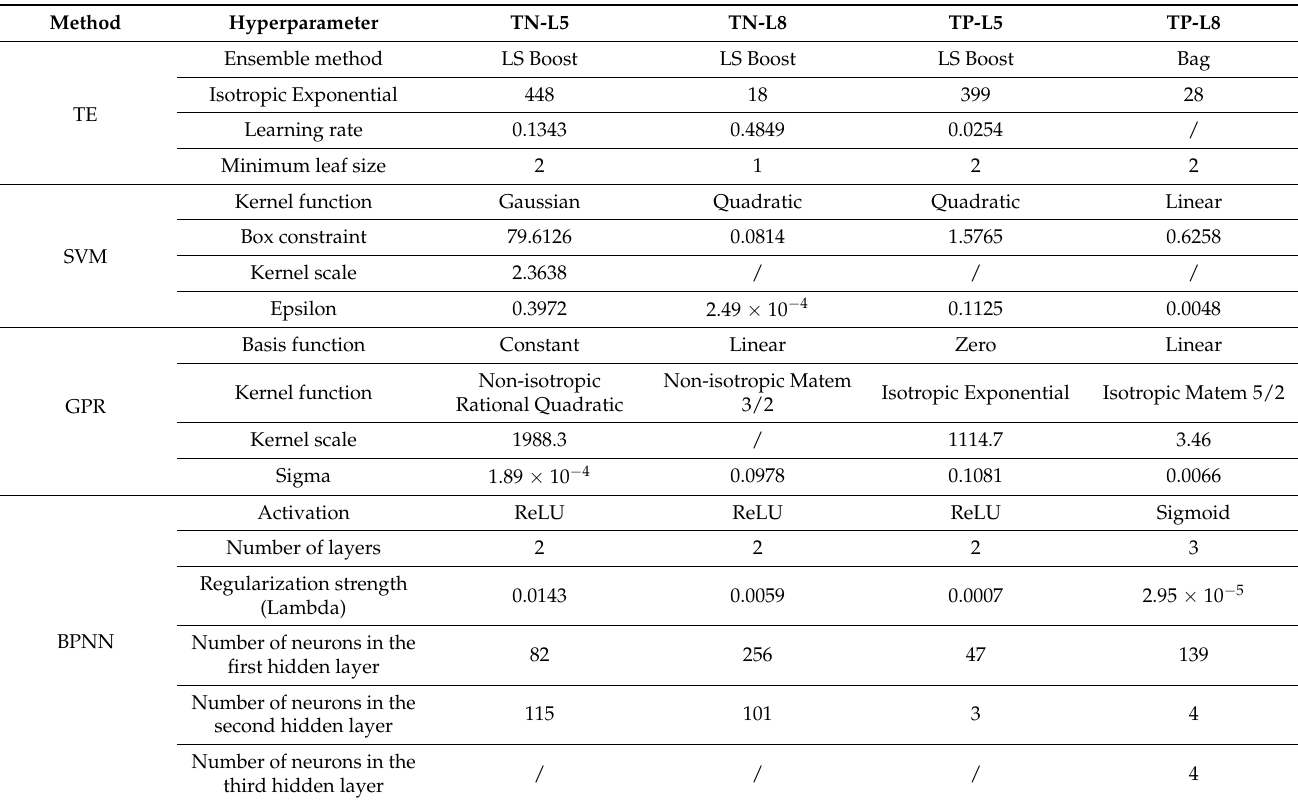
Table 1. Best hyperparameter combinations for the respective methods of Tree Embedding (TE), Support Vector Regression (SVR), Gaussian Process Regression (GPR), and Back-propagation Neural Network